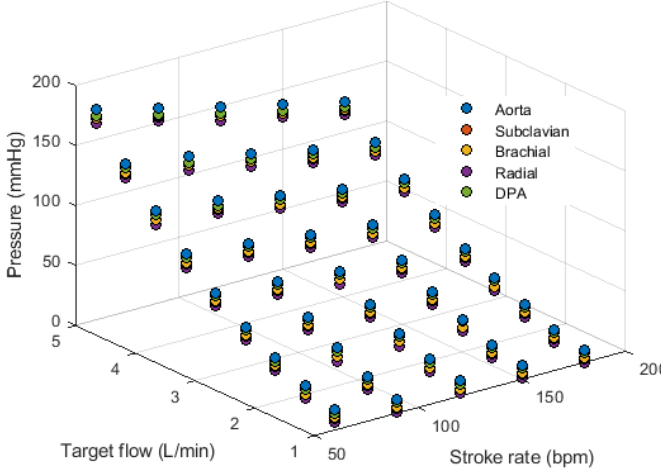
Figure 4. Behaviour of mean pressure measured from the aorta, subclavian, brachial, radial and deep palmar arch (DPA) locations while changing stroke rate and target flow.